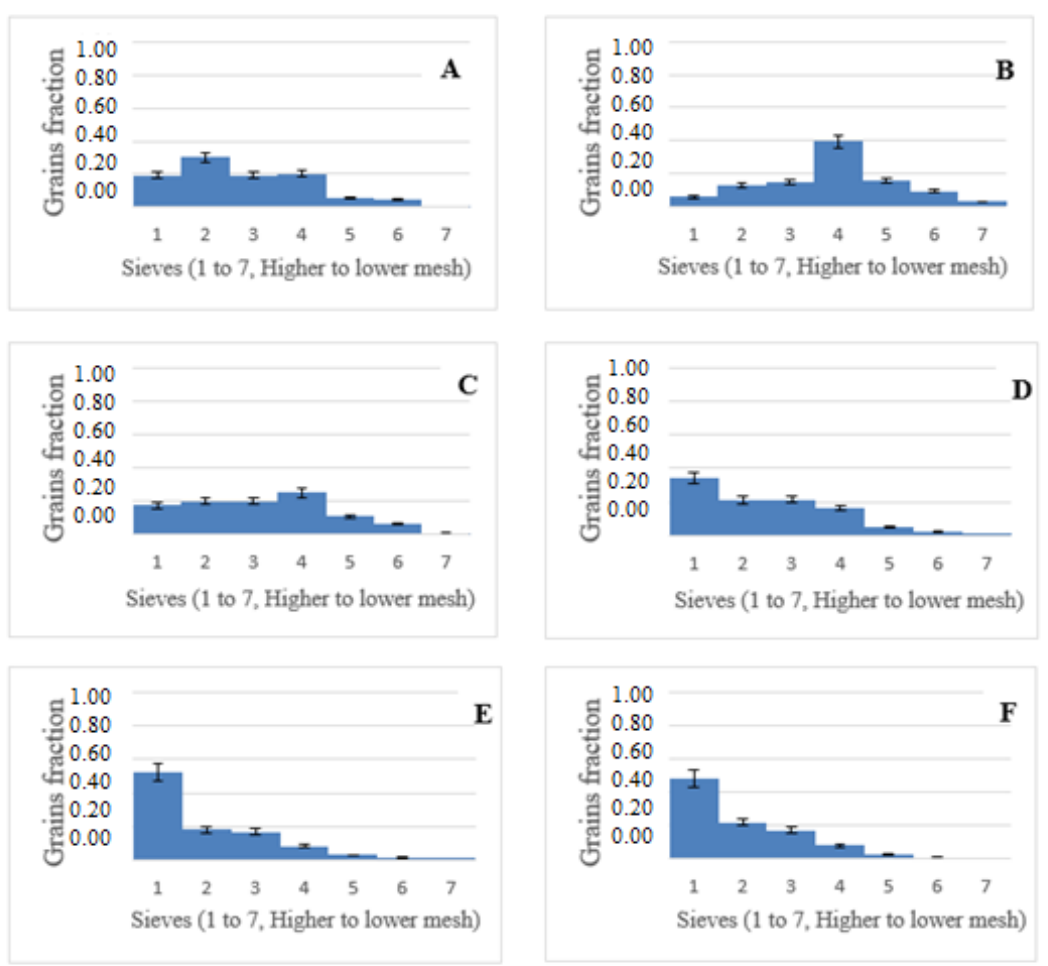
Figure 1. Granulometric distribution profiles of milled grain: dry ( A ); 10% moisture ( B ); 20% moisture ( C ); 30% moisture ( D ); 40% moisture ( E ); and 50% moisture ( F ).